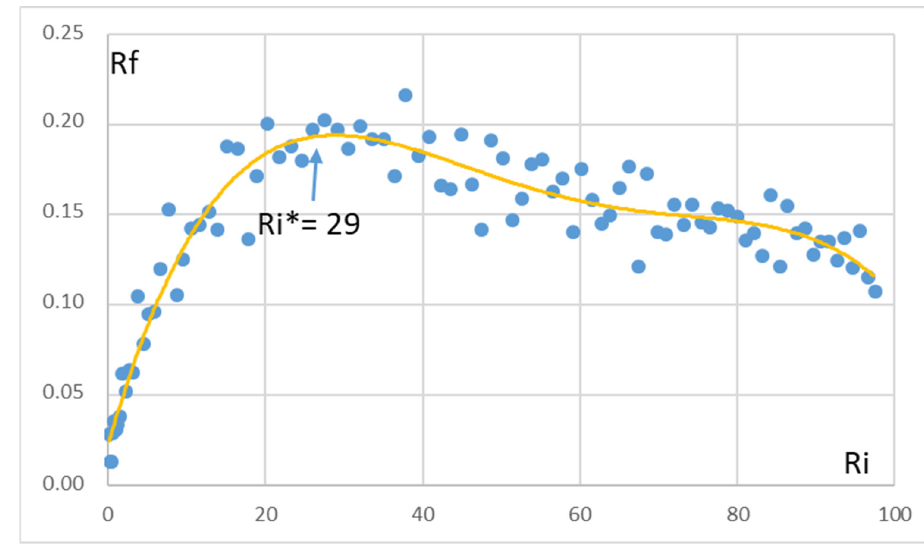
initial = 100 and Re = 214.